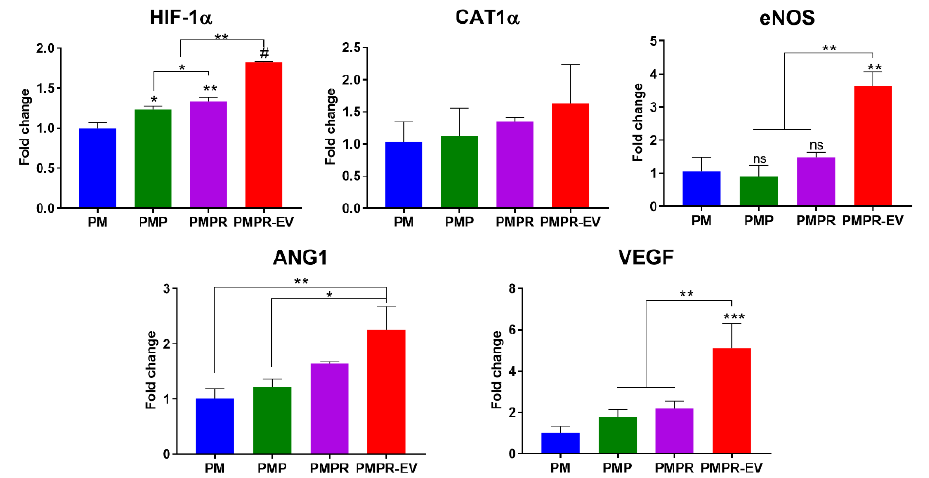
Figure 7. Genetic evaluation of HUVECs using NO-related genes, including eNOS, HIF-1 α , CAT1 α , ANG1, and VEGF by qRT-PCR. * p < 0.05, ** p < 0.01, *** p < 0.001, and # p < 0.0001 indicate statistically significant differences, respectively.